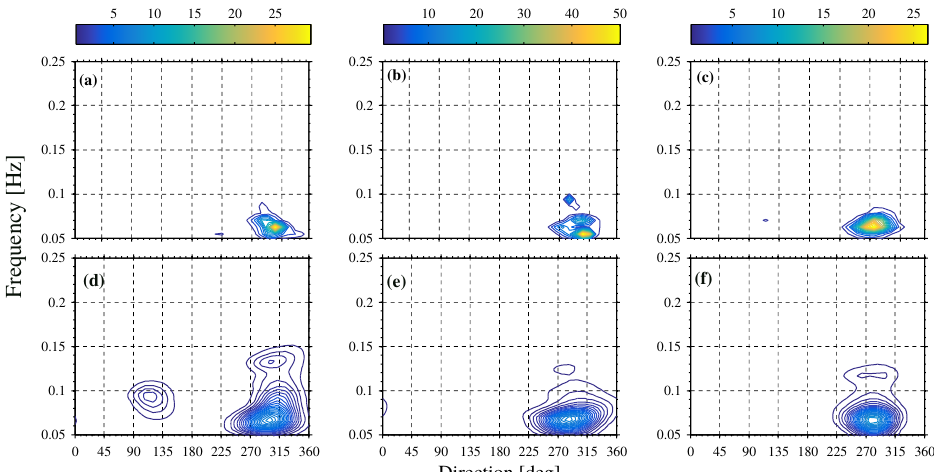
Figure 5. Radar and in situ estimates of wave directional spectra on 21 October 2012 at 1000 UTC. The upper panels show the results obtained from the in situ measurements, and the bottom panels show the radar estimates: ADCP-E spectra ( a , d ); and ADCP-W ( b , e ). Wave buoy ( c , f ). The colorbar represents the directional energy density (m 2 /Hz/deg).